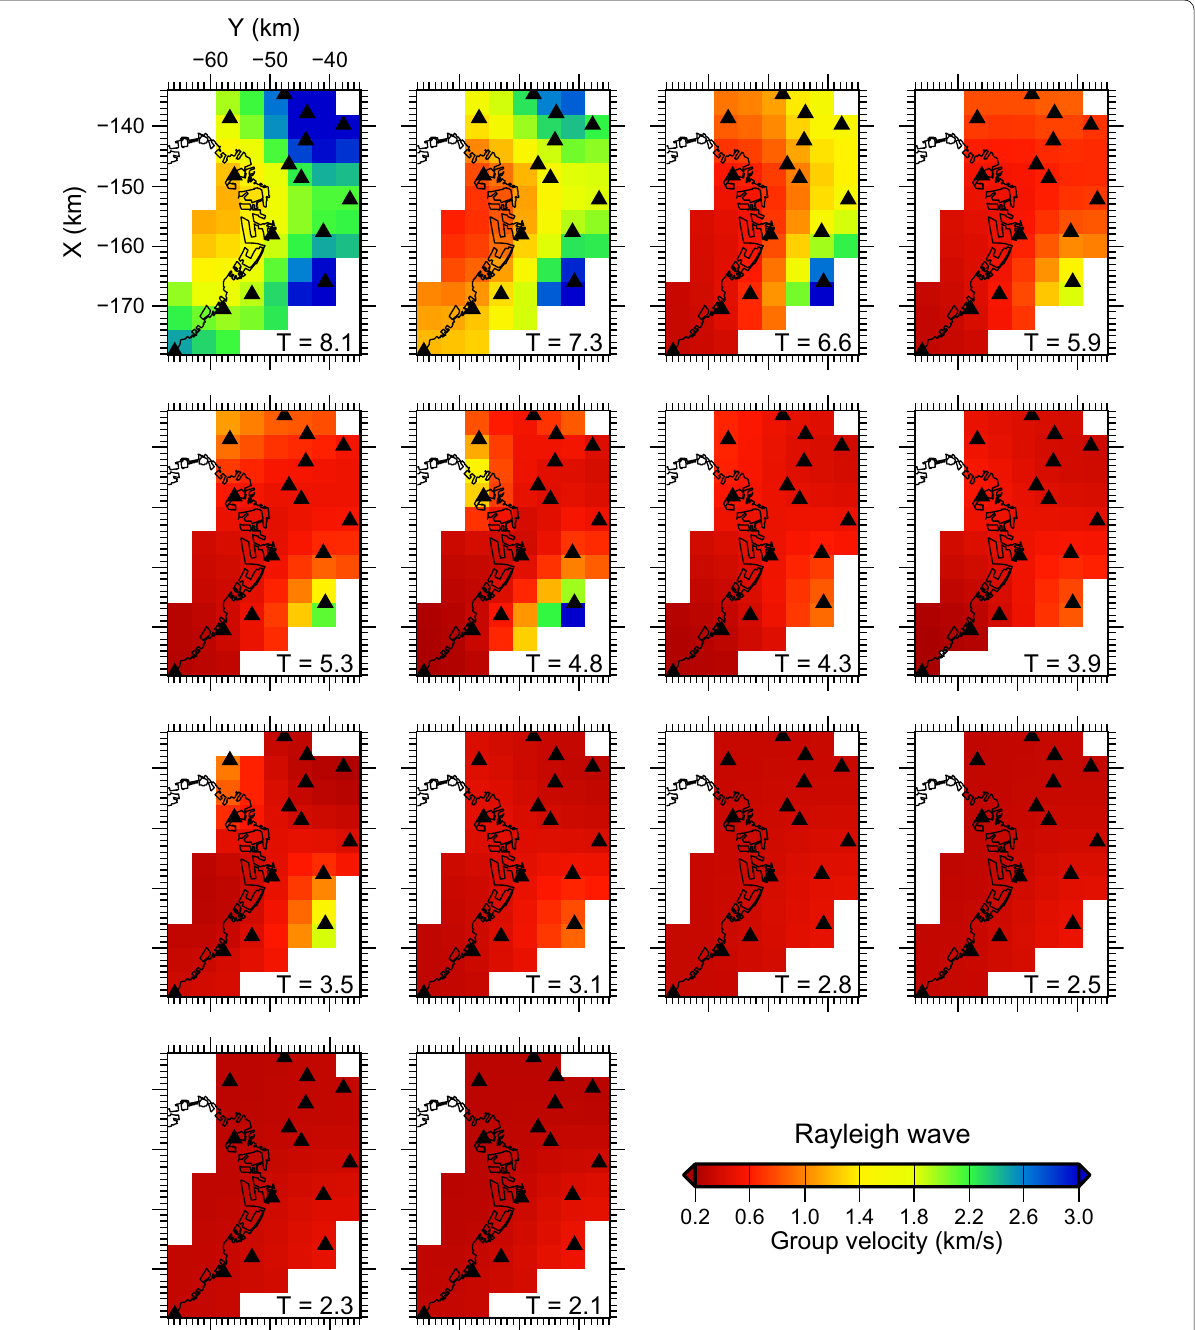
Fig. 11 Maps showing group velocities of Rayleigh waves in the period range 2.1–8.1 s estimated from group delay times of inter-station Green’s functions. The solid triangles indicate temporary